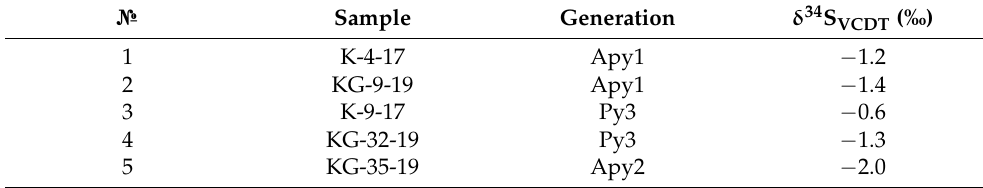
Table 4. Sulfur isotopic composition of sulfides from metasomatites of Khangalas deposit. №